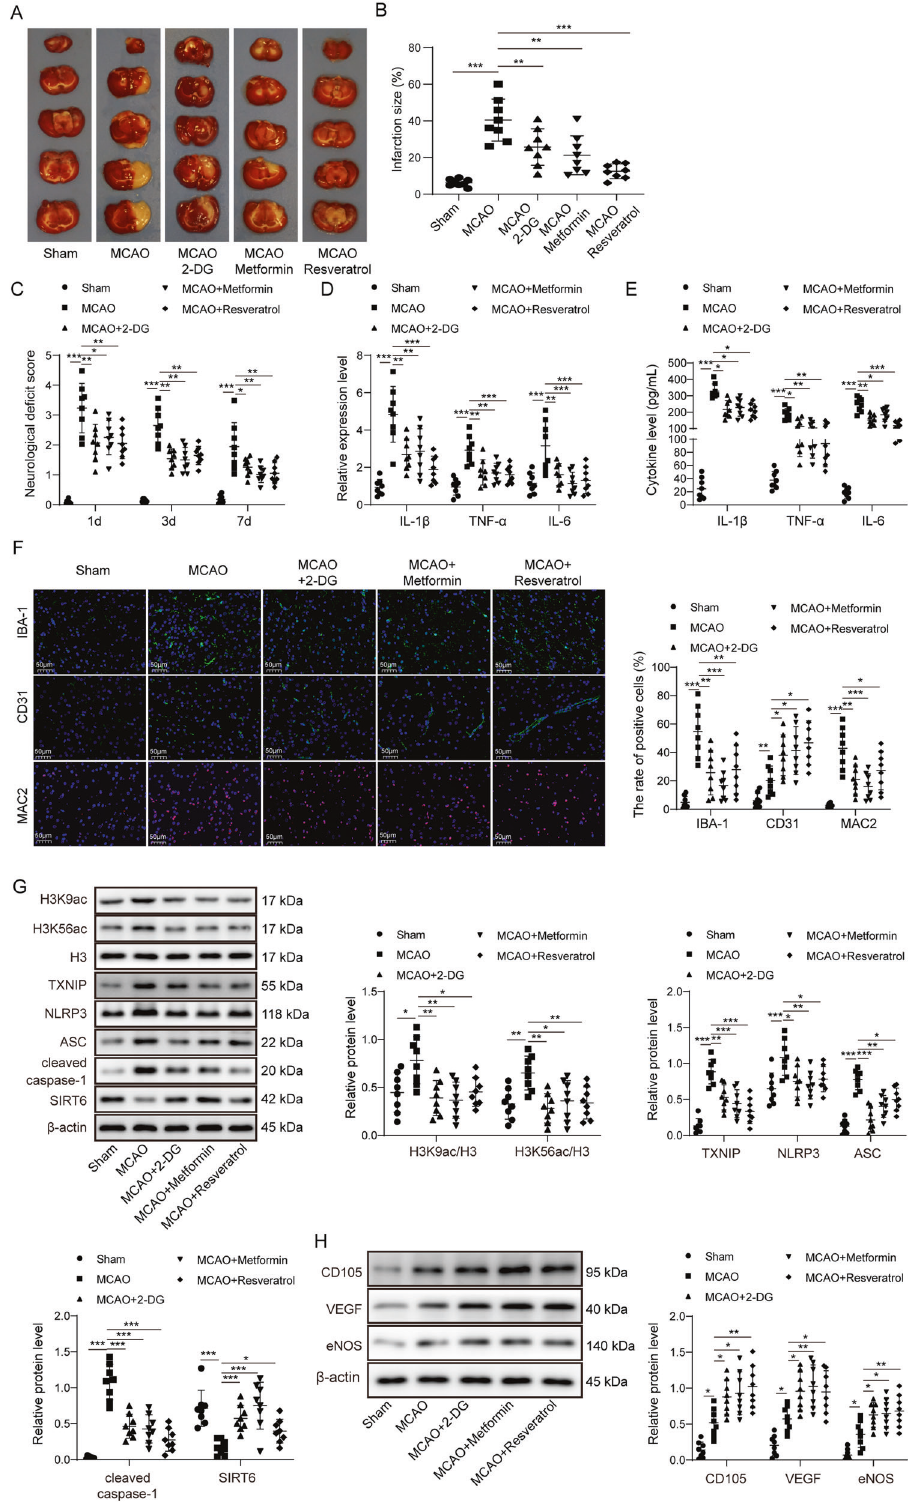
Fig. 2 ER mimetics exerted similar effects as IF in vivo. A TTC stained sections illustrating normal (red) and infarct area (white). B The size of infarct area was expressed as percentage (%) of brain volume. C Neurological de fi cit scores using Longa scoring system. D , E The mRNA and serum levels of cytokines were determined by qRT-PCR and ELISA assay, respectively. F Immuno fl uorescence staining of IBA-1 (Green), CD31 (Green) and MAC2 (Red) in the peri-infarct cortex. Blue, DAPI. Scale bar = 50 μ m. G , H The protein levels of target proteins were determined by Western blotting. β -actin acted as a loading control for Western blotting. For animal studies, n = 8/group. * p < 0.05, ** p < 0.01, and *** p < 0.001.